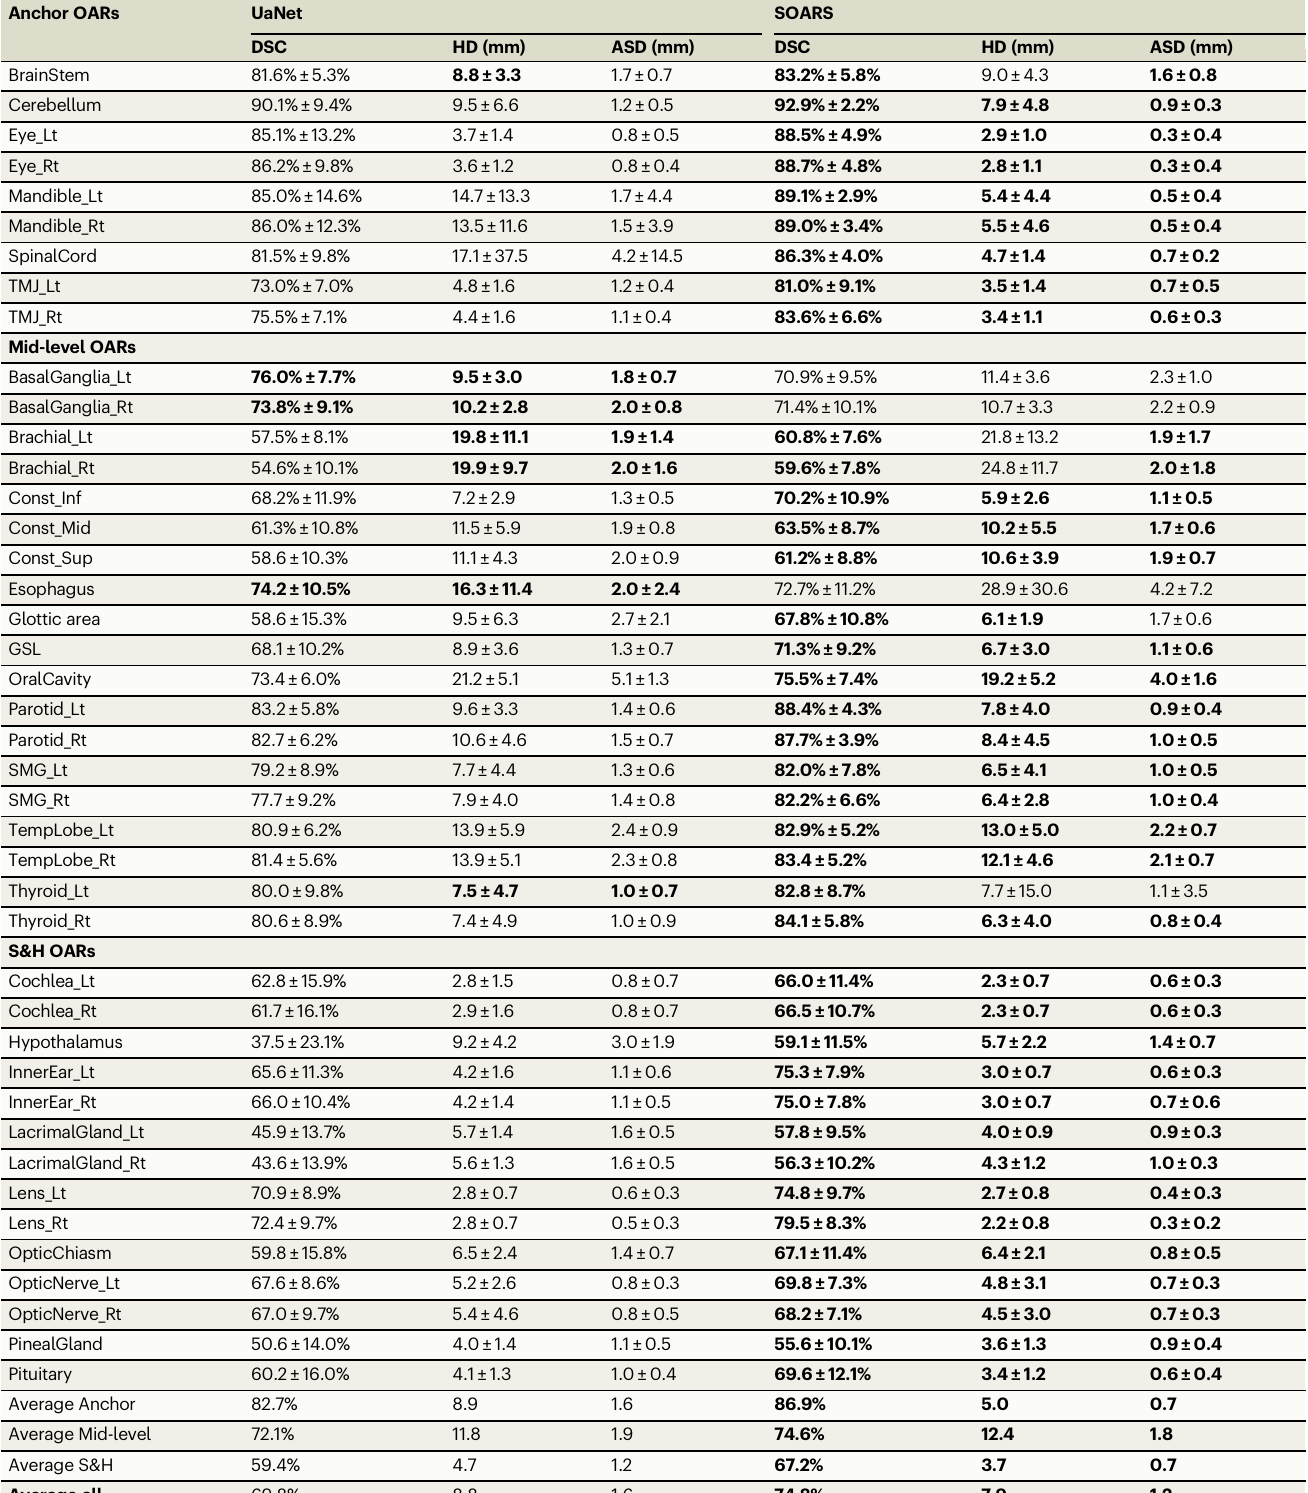
Table 3 | Quantitative comparisons of the internal testing of 326